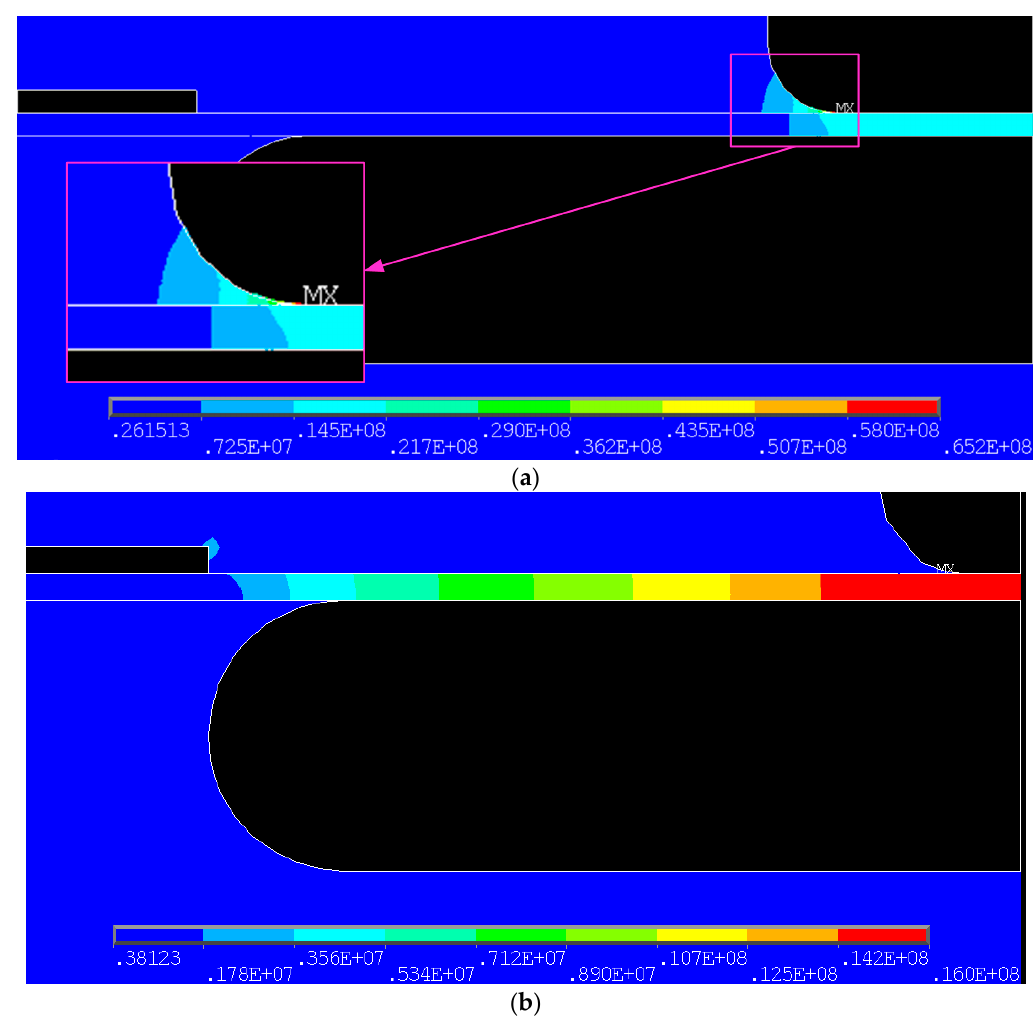
Figure 8. Space charge distribution diagram under DC component. ( a ) Needle-plate; ( b ) Surface discharge; ( c ) Air gap.